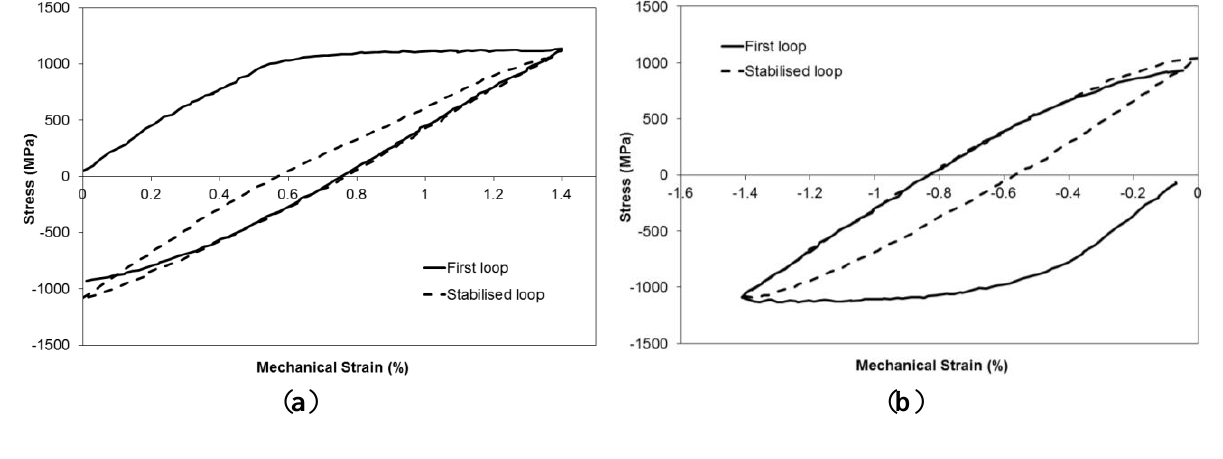
Table 1. Experimental